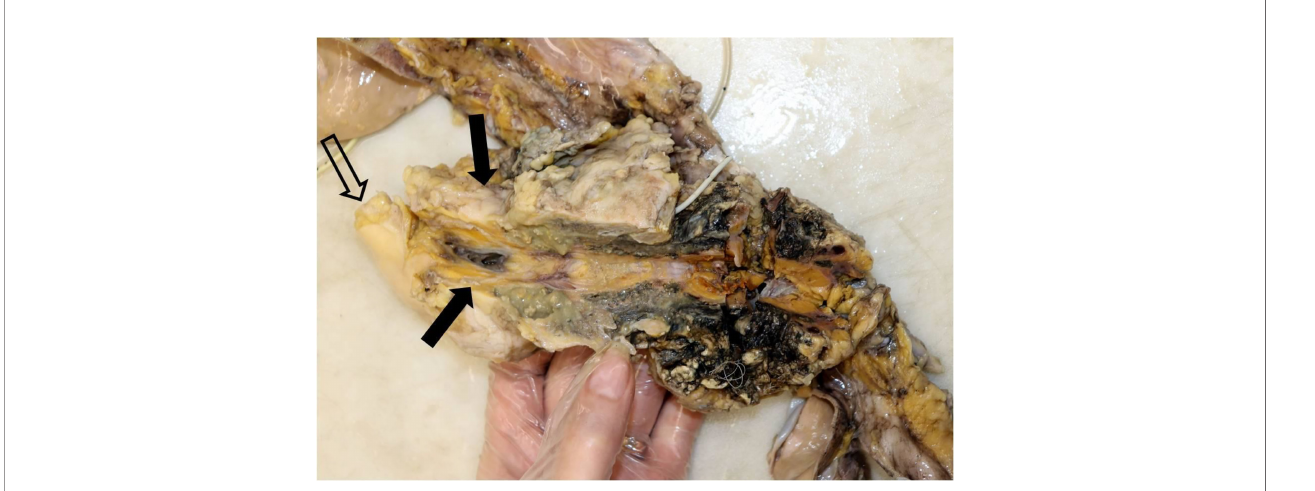
FIGURE 4 | Macroscopic examination of the pancreas, sectioned longitudinally. Single arrows, head of the pancreas, with no visible tumor lesion; twin open arrows,